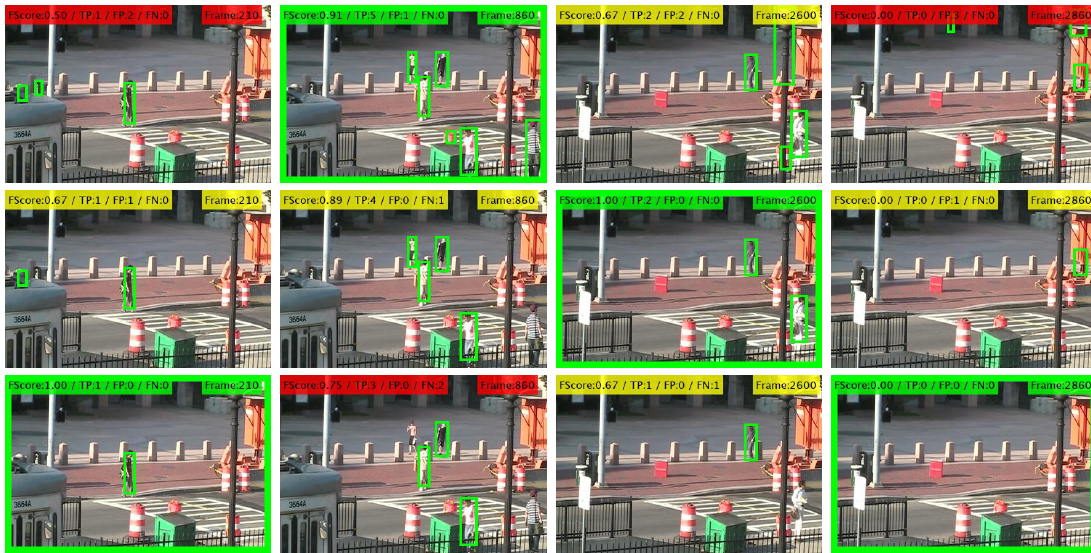
Figure 1. People detection results for Faster R-CNN [1] of detectors (sequence tramstop , http://www- and false negative detections (FN). Each row corresponds to applying a detection threshold with values 0.24 (Row 1), 0.5 (Row 2) and 0.75 (Row 3). Finding an optimal threshold (framed in green) for all cases is challenging due to the variability of viewpoints, people sizes and